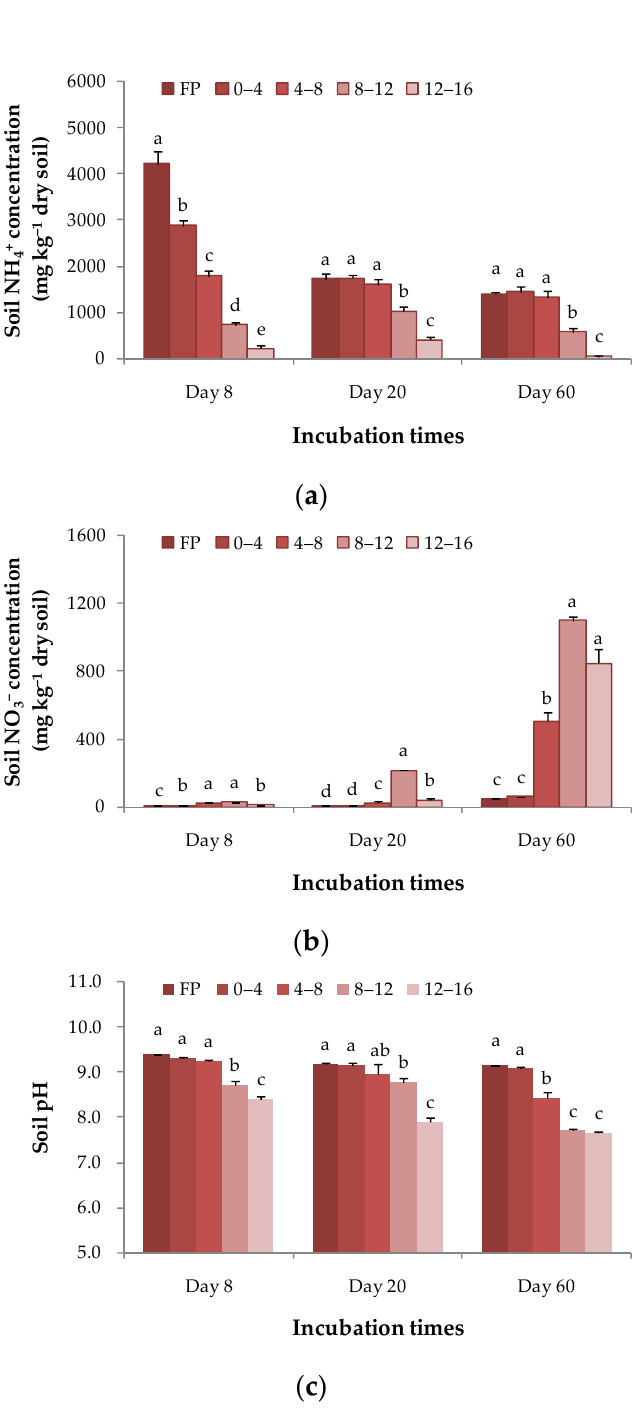
Figure 2. The soil mineral nitrogen concentration and pH value in different treatments and incubation time for Qidong (QD) soil. ( a ) Soil NH 4+ concentration; ( b ) soil NO 3 − concentration; ( c ) soil pH value. Day 8: samples at 8 days after urea application. Day 20: samples at 20 days after urea application. Day 60: samples at 60 days after urea application. Data are means ± SE (standard er ‐